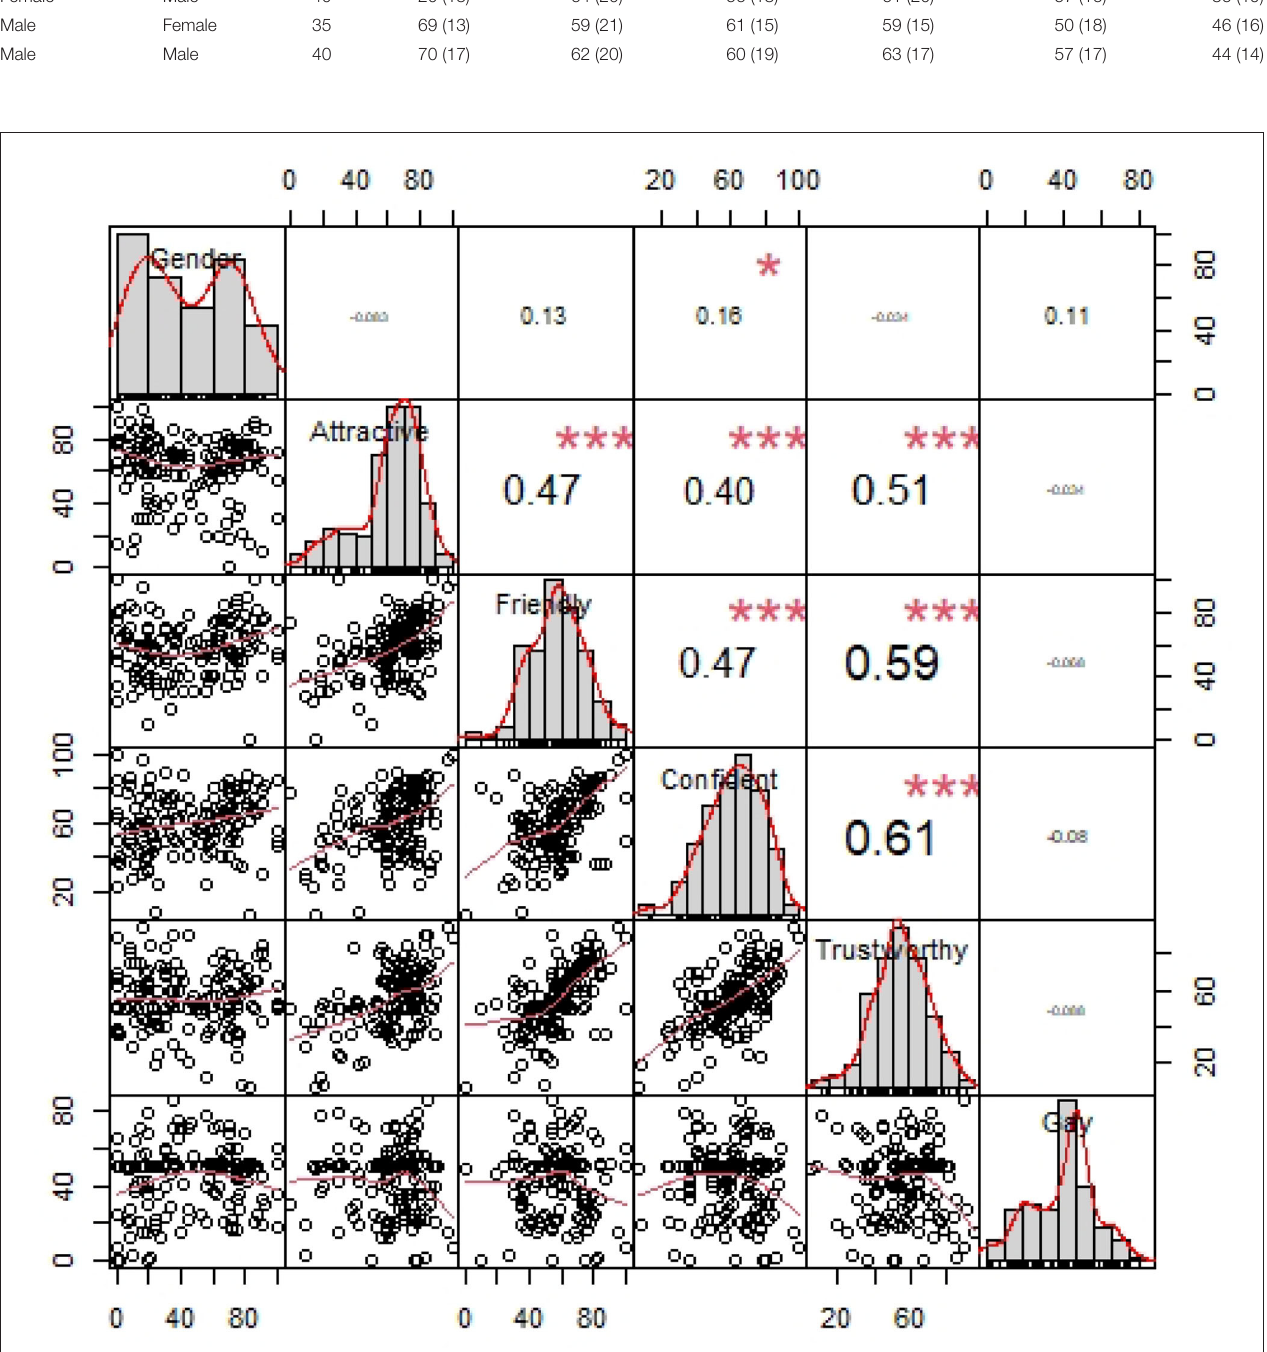
FIGURE 5 | Correlations between the ratings across different visual attributes. Each point corresponds to the ratings of a participant. ∗∗∗ p < 0.001; ∗ p < 0.05.